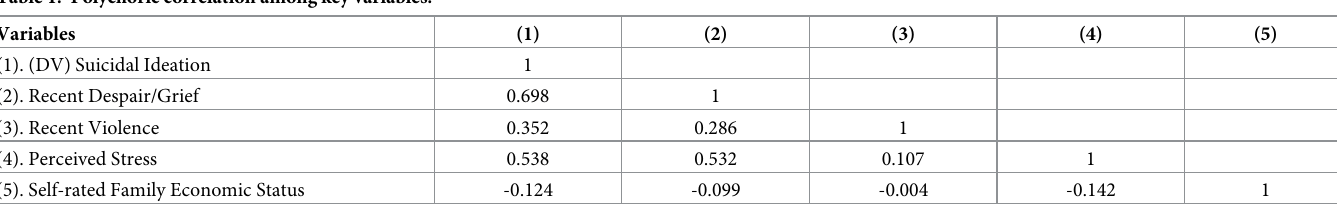
Table 1. Polychoric correlation among key variables.